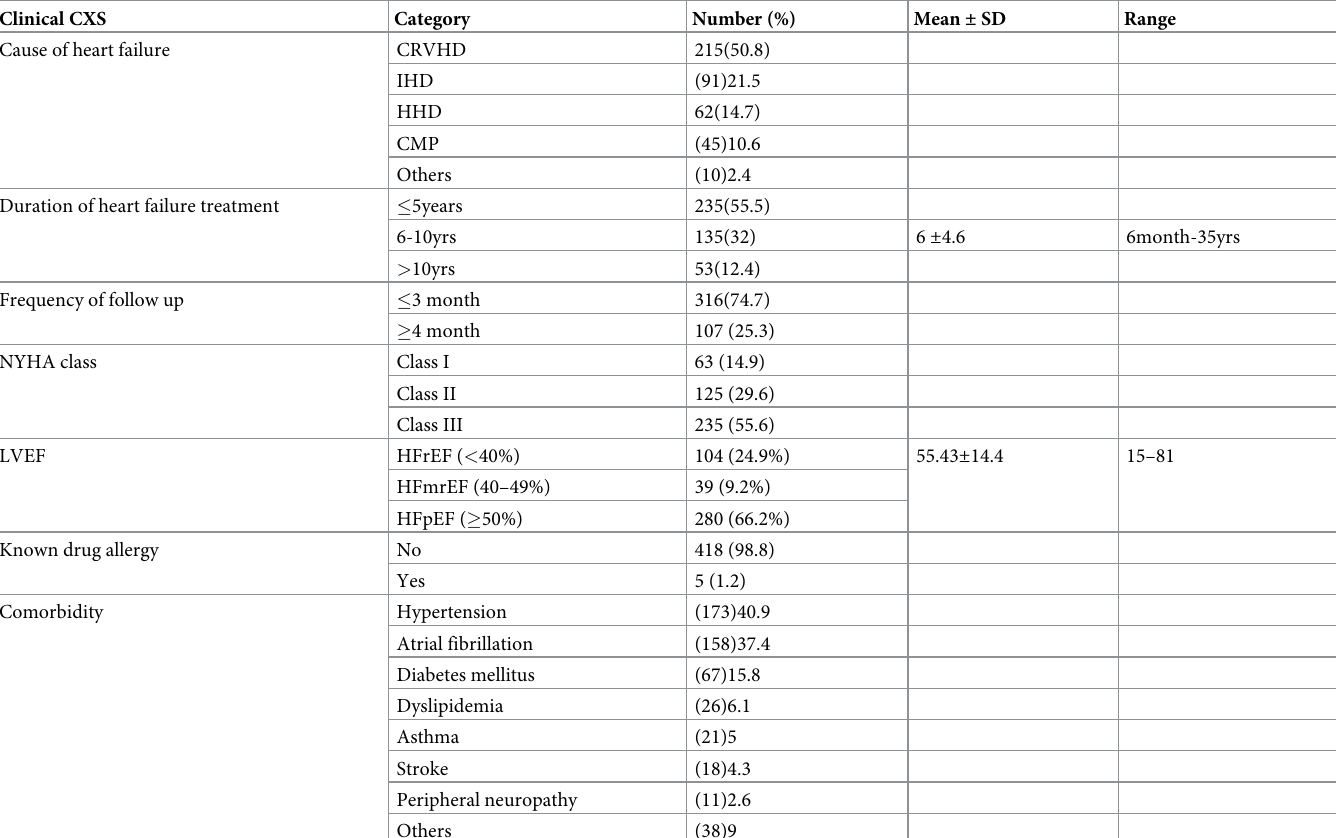
� Other: Degenerative valvular heart disease, corpulomonale, congenital heart disease; CMP: cardiomyopathy, CRVHD: chronic rheumatic valvular heart disease, IHD: ischemic heart disease, HHD: hypertensive heart disease, HFrEF: heart failure with reduced ejection fraction, HFmrEF: heart failure with mid-range ejection fraction, HFpEF: heart failure with preserved ejection fraction, LVEF: left ventricular ejection